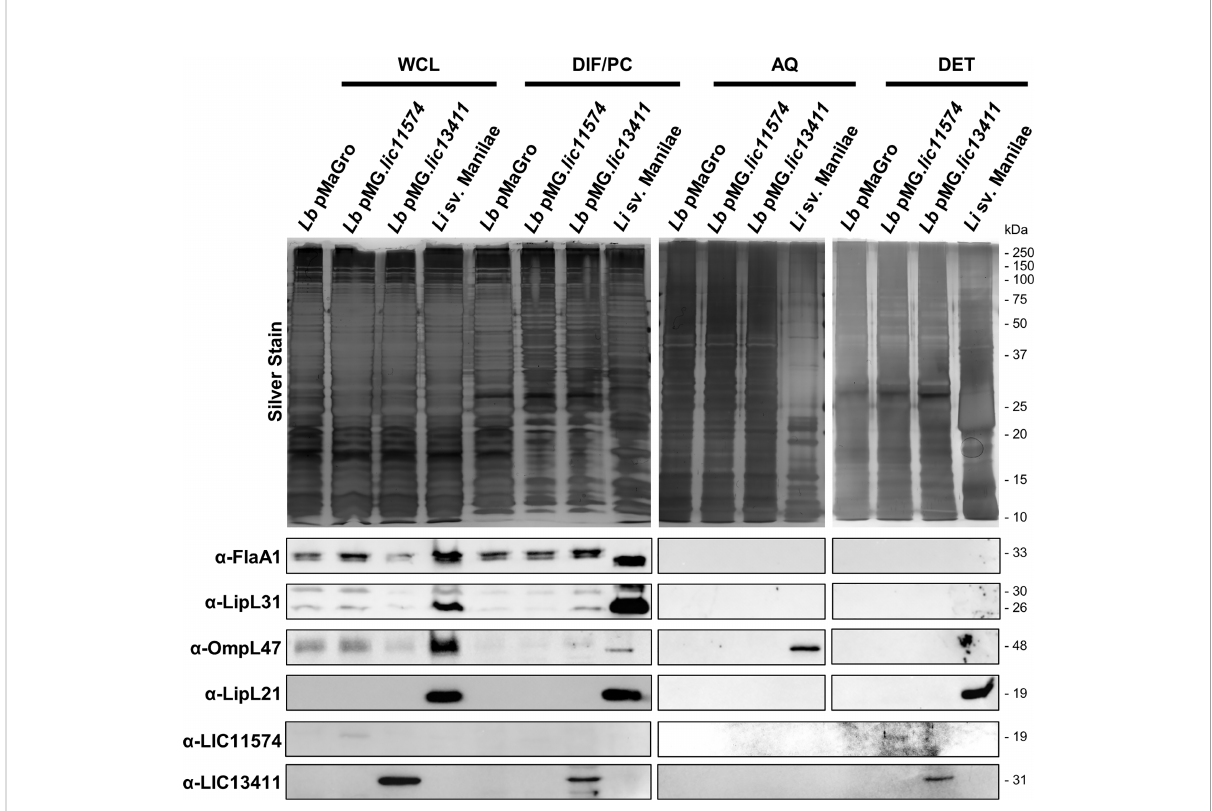
FIGURE 3 Adhesins produced in L. bi fl exa localize to the outer membrane. Leptospira strains were fractionated using Triton X-114. Samples corresponding to 4 × 10 8 Leptospira cell equivalents were loaded in each lane corresponding to whole-cell lysate (WCL), detergent-insoluble fraction/ protoplasmic cylinder (DIF/PC), aqueous (AQ), and detergent (DET) fractions. A silver stain was performed on each fraction to show protein loaded (top). A bubble is present in the silver stain of the DET fraction of L. interrogans sv. Manilae. Immunoblots were performed using sera against periplasmic protein fl agellin A1 (FlaA1), inner membrane protein LipL31, outer membrane proteins OmpL47 and LipL21, and af fi nity- puri fi ed mouse sera against LIC11574 and LIC13411. Both candidate adhesins are produced in the gain-of-function (GOF) strains. Candidate adhesin LIC11574 localizes to the DET fraction; however, to identify the band, the brightness and contrast of the image were increased 40% and 60%, respectively. LIC13411 localizes to the DIF/PC and DET